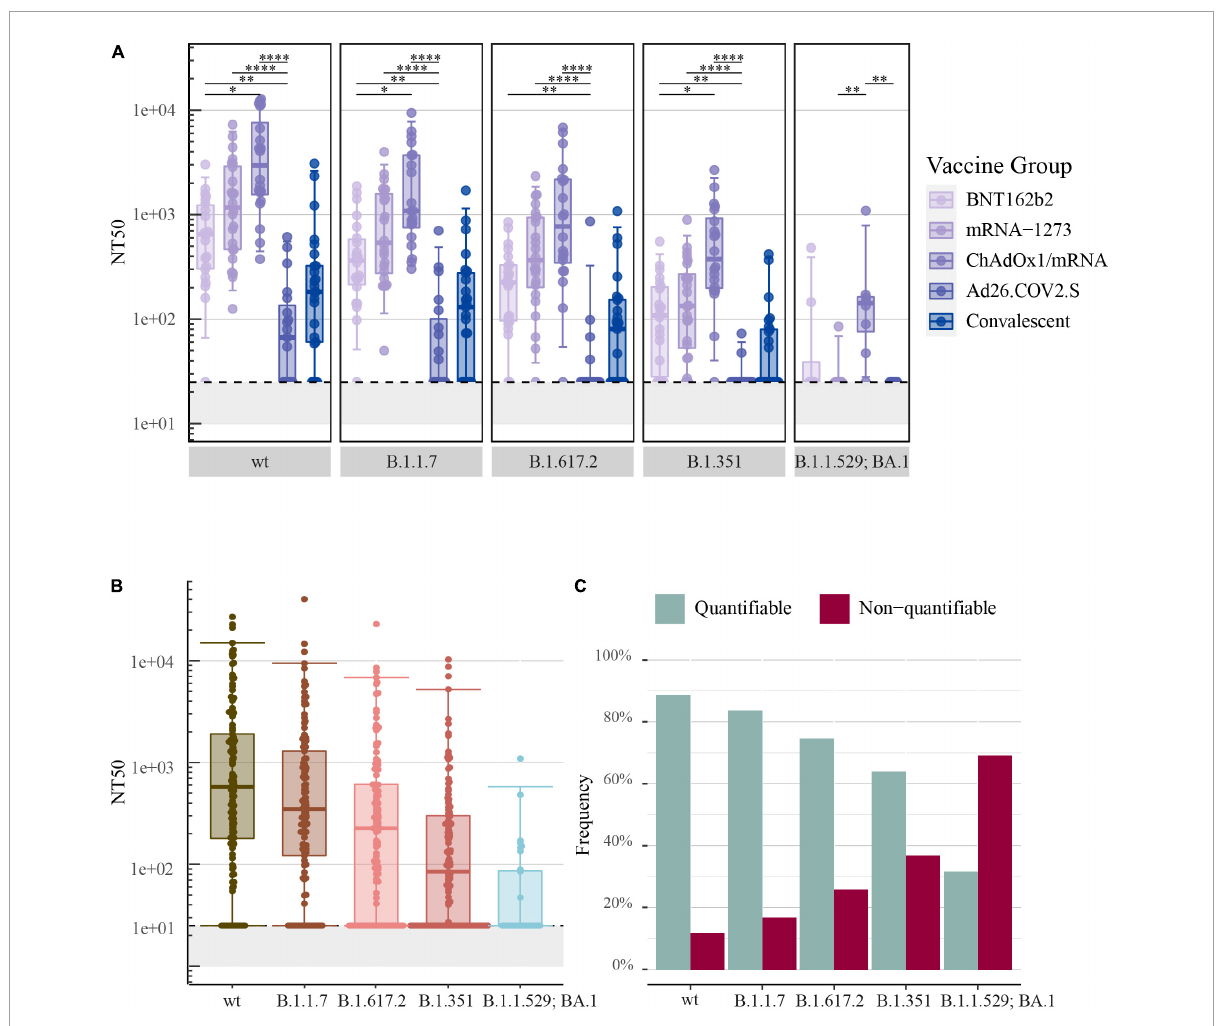
FIGURE2 Neutralizing antibody responses to pseudoviral SARS-CoV-2-S after COVID-19 vaccination: (A) The 50% neutralization titers (NT50) induced by primary COVID-19 vaccination with BNT162b2 ( n = 22), mRNA-1273 ( n = 24), ChAdOx1/mRNA ( n = 20) or Ad26.COV2.S ( n = 19) quantified by the pseudovirus neutralization assay. Data from convalescent comparators ( n = 25) are also displayed, but are not included in the statistical analysis. (B) NT50 values merged for all vaccine types. (C) The frequency of quantifiable ( > 25) and non-quantifiable ( ≤ 25) NT50 values merged for all vaccine types. From left to right: SARS-CoV-2-S wt (Wuhan-Hu-1 including D614G) and the following SARS-CoV-2-S VOCs: B.1.1.7 (Alpha), B.1.617.2 (Delta), B.1.351 (Beta) and B.1.1.529; BA.1 (Omicron) (B.1.1.529; BA.1, n = 32: eight individuals per vaccine group). All boxplots present the lower quartile, median and upper quartile, and the error bars indicate 95% CI. P -values were indicated as follows: ∗ p ≤ 0.05, ∗∗ p < 0.01, and ∗∗∗∗ p <